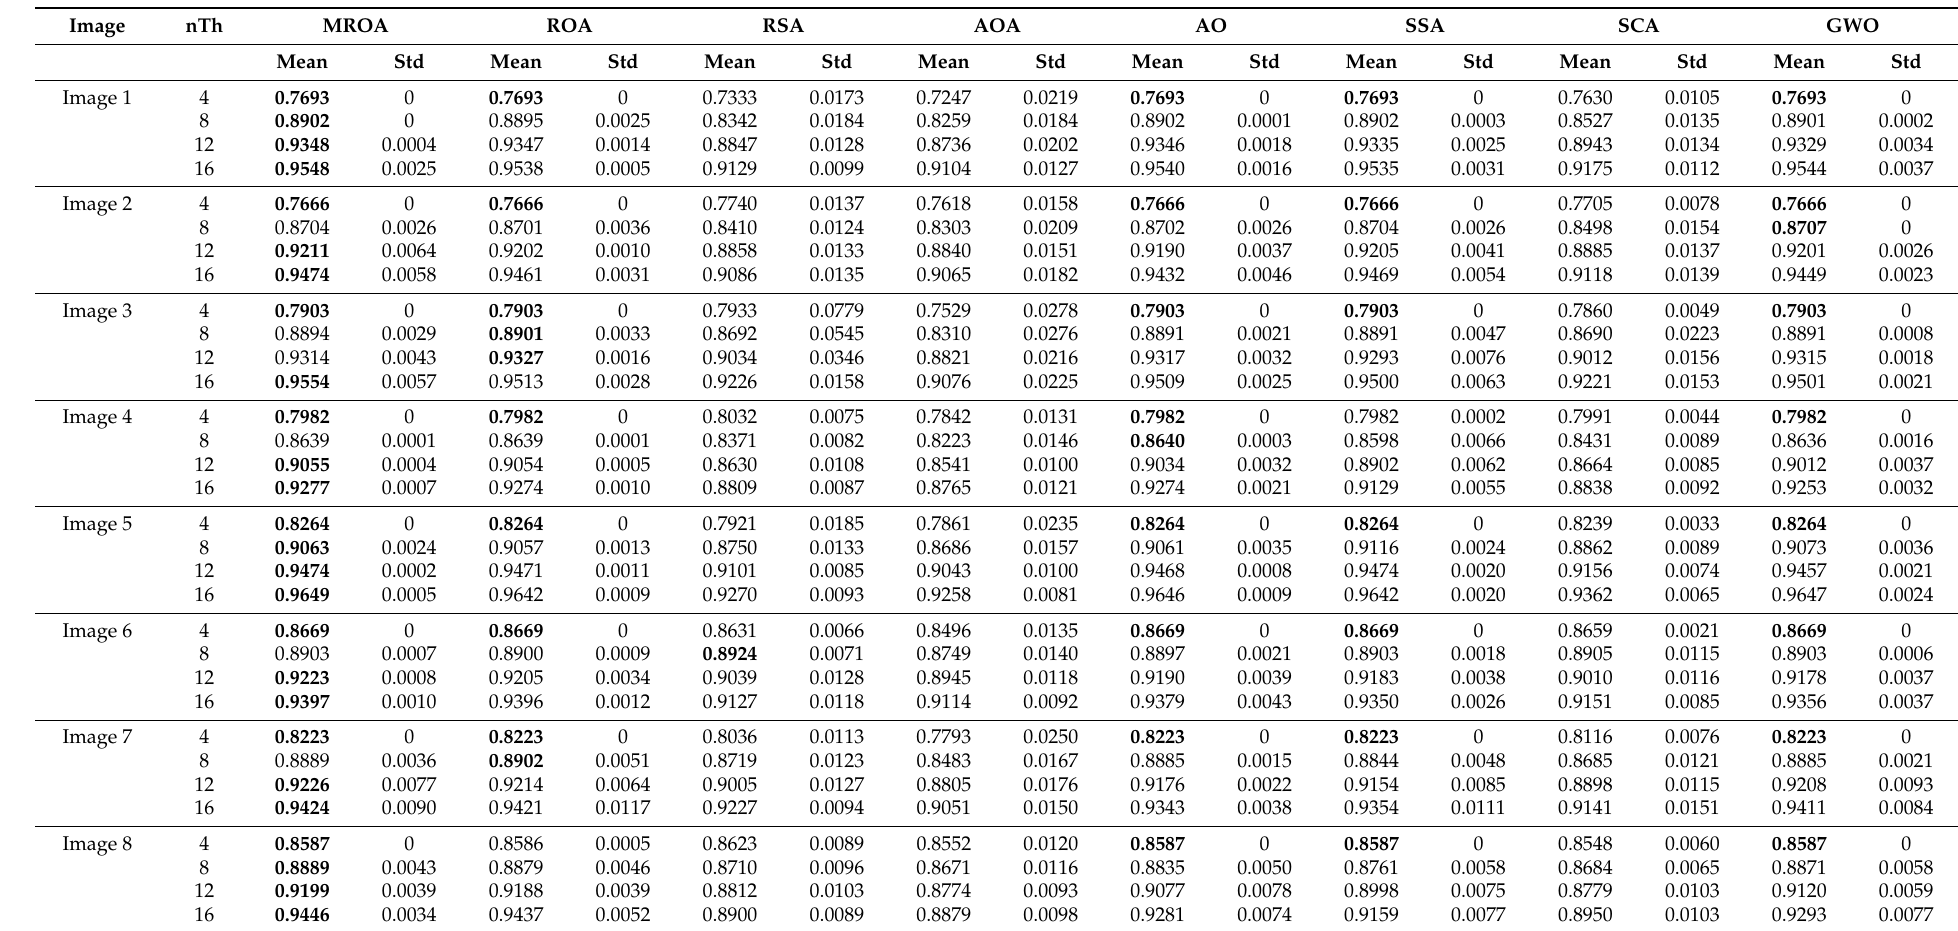
Table A6. The FSIM values obtained by algorithms over all